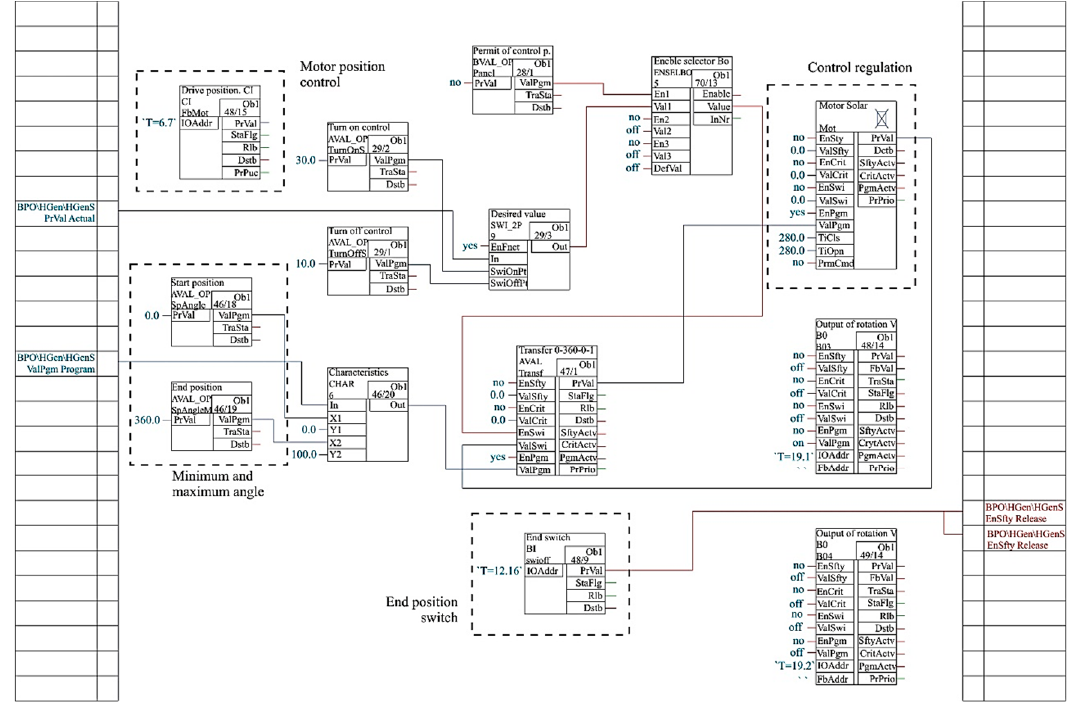
Figure 7. Block diagram of a control system of a construction rotation.